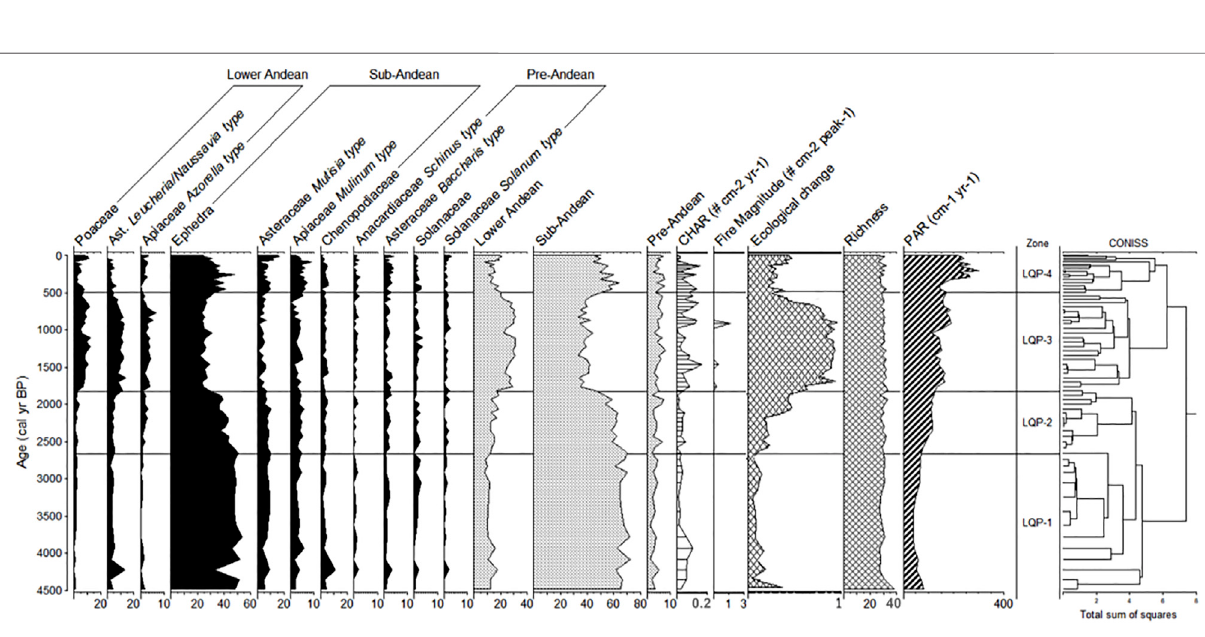
FIGURE 5| Pollen diagram ofthe percentage of the main taxa ofLagunaQuebrada Parada. The carbon accumulation rate “ CHAR ” (# particles cm-2 years-1), the magnitude of the fi re (# particles cm-2 peak-1), and the pollen accumulation rate “ PAR ” (# pollen grains cm-2 years-1) are shown. The values of the ecological change and the pollen richness recorded throughout the record are also